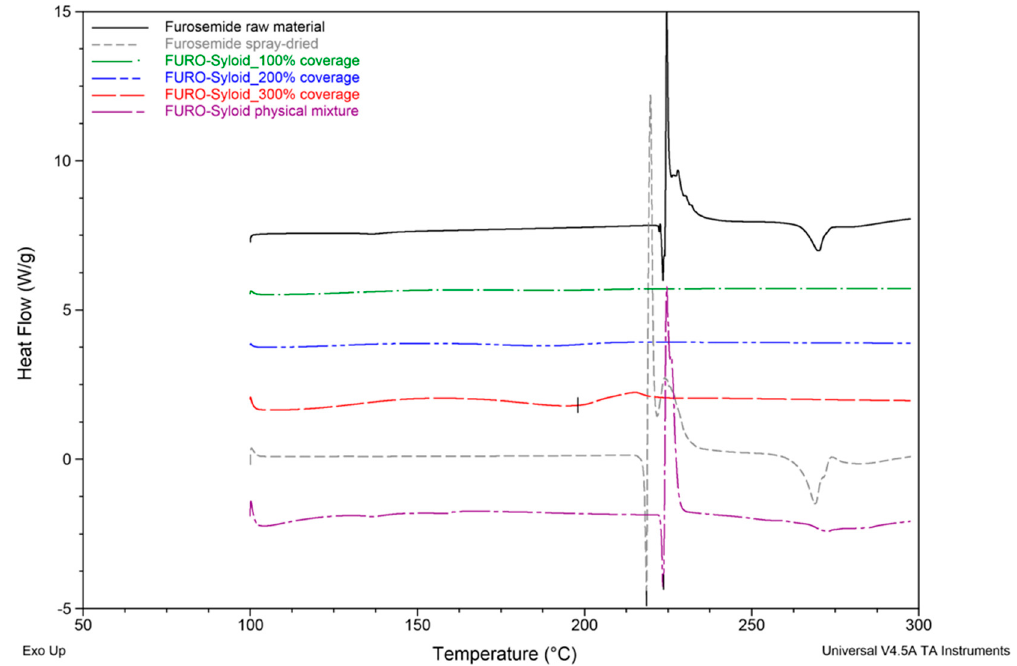
Figure 3. DSC thermograms of Furosemide raw and spray-dried materials, Furosemide (FURO)-Syloid formulations at various drug loads, FURO-Syloid physical mixture.